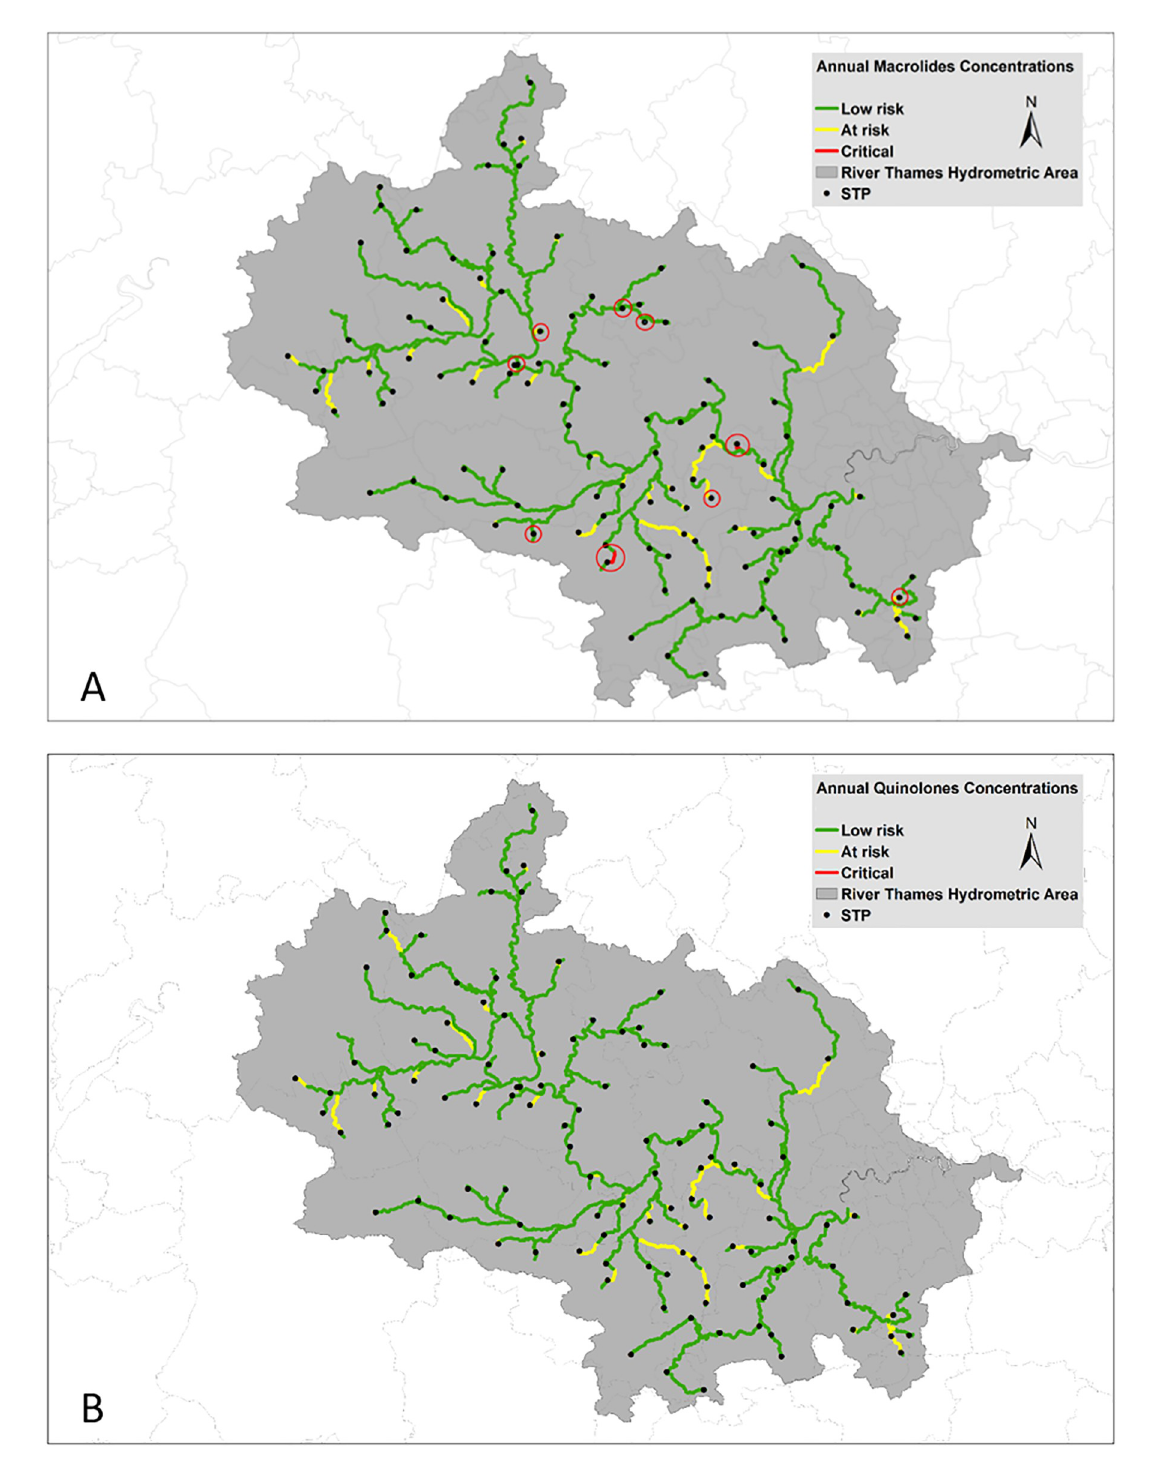
Fig 4. Hazard characterisation for (A) macrolide and (B) fluoroquinolone resistance selection after a reduction of 77% and 85% in prescriptions, respectively, on 2015/16 rates. Red circles in (A) indicate nine locations where the concentrations remained ‘at critical’ levels.